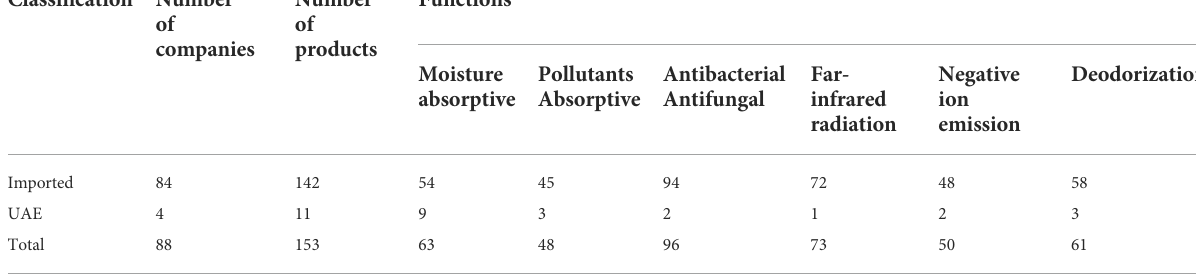
TABLE 1 Current Status of Functional Building Materials distributed in